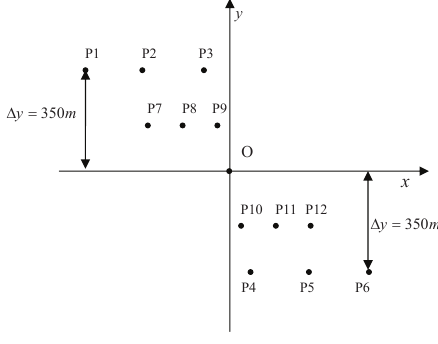
Figure 5. Target area used in the simulation.